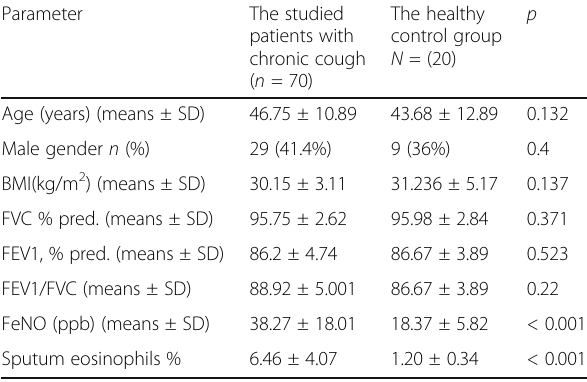
Table 1 Baseline characteristics of the studied patients with chronic cough and the healthy control group Parameter The studied patients with